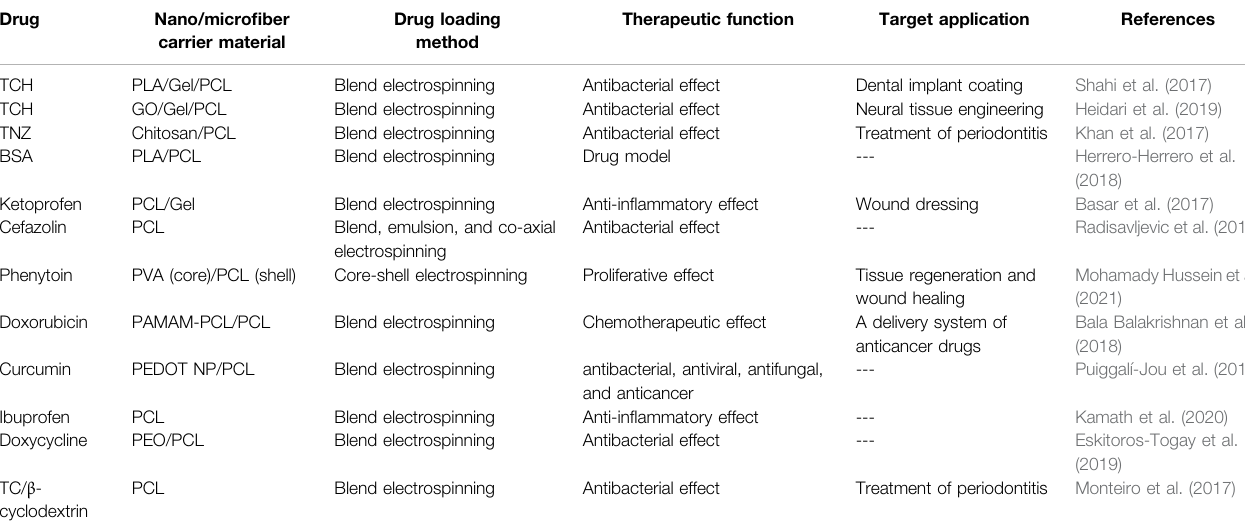
TABLE 3 | Drug loaded PCL-based nano fi bers for biomedical applications (studies reported after